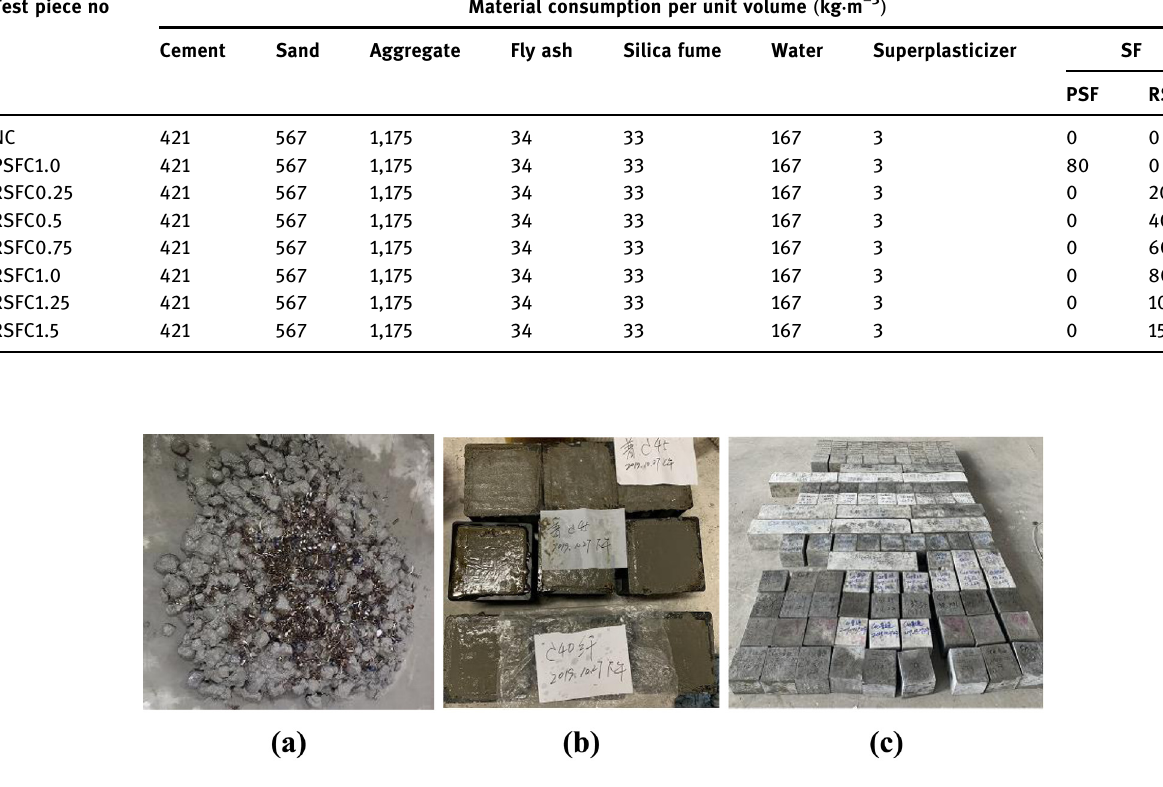
Figure 2: Fabrication process of test block: ( a ) mixture mixing, ( b ) molding, and ( c ) curing